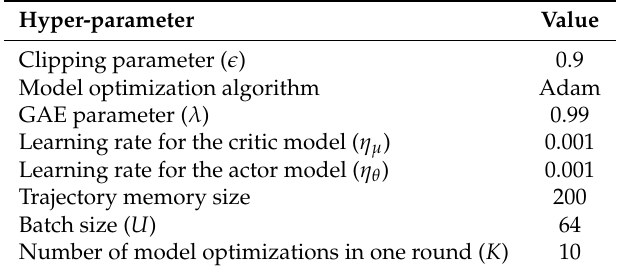
Table 1. Hyper-parameter configuration for Actor–Critic